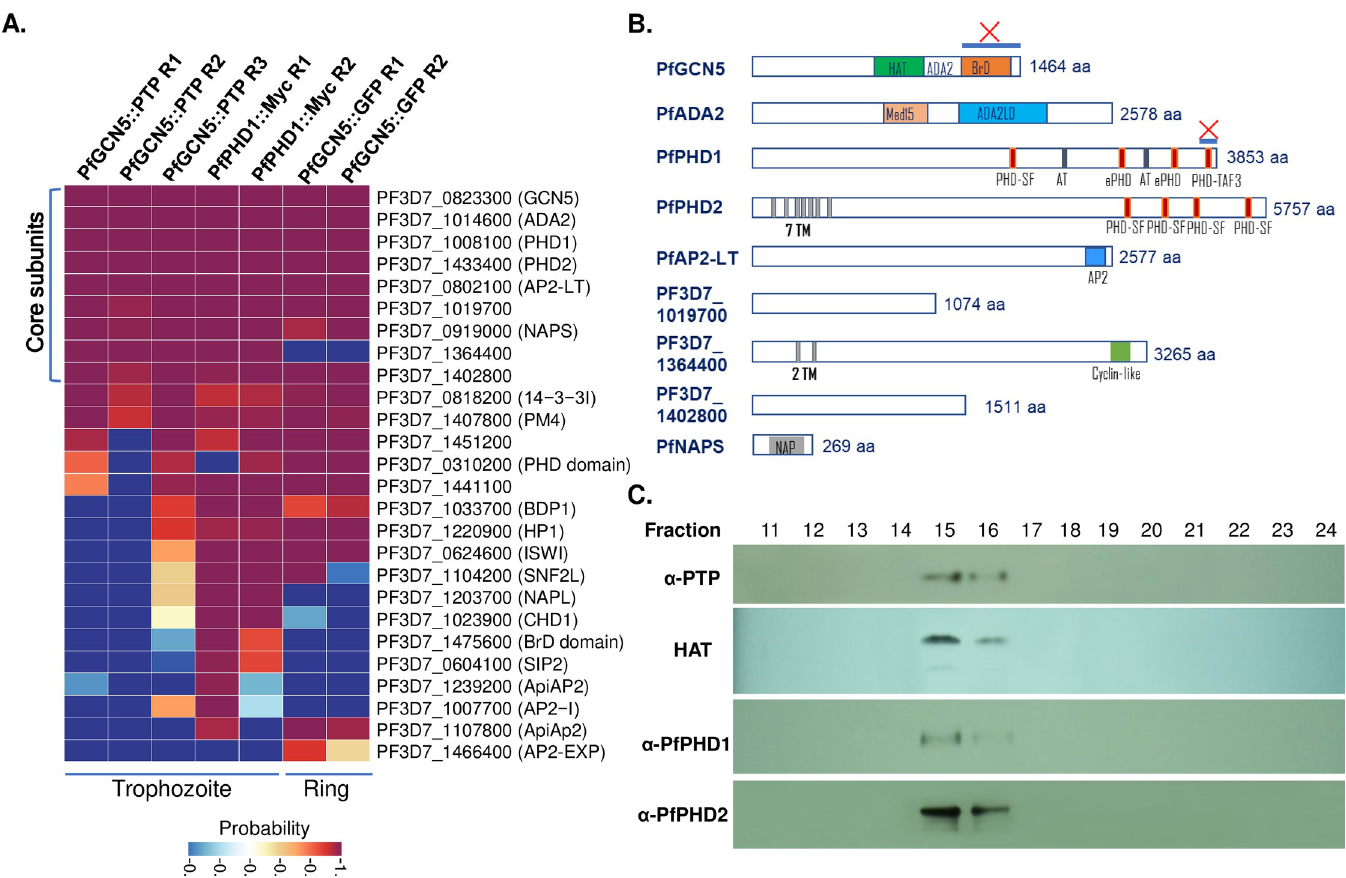
Fig 1. Identification of the PfGCN5 Core Complex in P . falciparum . (A) Proteins identified from parasite nuclear extracts by IP and by LC-MS/MS. TAP procedure was performed using the PfGCN5::PTP line at the trophozoite stage (three replicates R1 –R3), while single-step IPs with the anti-Myc and anti-GFP beads were done using the PfPHD1::Myc parasite line at the trophozoite stage and PfGCN5::GFP at the ring stage (two replicates, R1, and R2). The wildtype 3D7 was used as IP control. The wildtype 3D7 was used as IP control. The proteomic data were analyzed by SAINT using a threshold of probability > 94% and 1% FDR. Nine proteins consistently identified are marked as the PfGCN5 complex core subunits. Gene ID and annotation are shown on the right. (B) Schematic diagrams showing the features (putative domains and protein size) of the core subunits. HAT: histone acetyltransferase enzymatic domain; ADA2: ADA2 binding domain; BrD: Bromodomain; Med15: Med15 domain; ADA2LD: ASA2-like domain; PHD-SF: PHD finger superfamily; ePHD: extended PHD finger; PHD-TAF3: PHD finger homologous to transcription initiation factor TFIID subunit 3 (TAF3); AT: AT hook; TM: transmembrane region; AP2: AP2-domain; cyclin-like: cyclin-like domain; NAP: nucleosome assembly protein. The C-terminals of PfGCN5 and PfPHD1 labeled by the blue line and “X” containing BrD and PHD-TAF3 were deleted for functional studies (see details in S6 Fig). (C) Gel filtration analysis of the PfGCN5 complex. Aliquots of different fractions were used for Western blots with anti-PTP, PfPHD1 and PfPHD2 antibodies to detect full-length of PfGCN5, PfPHD1 and PfPHD2, and for the HAT assay using recombinant histone H3.